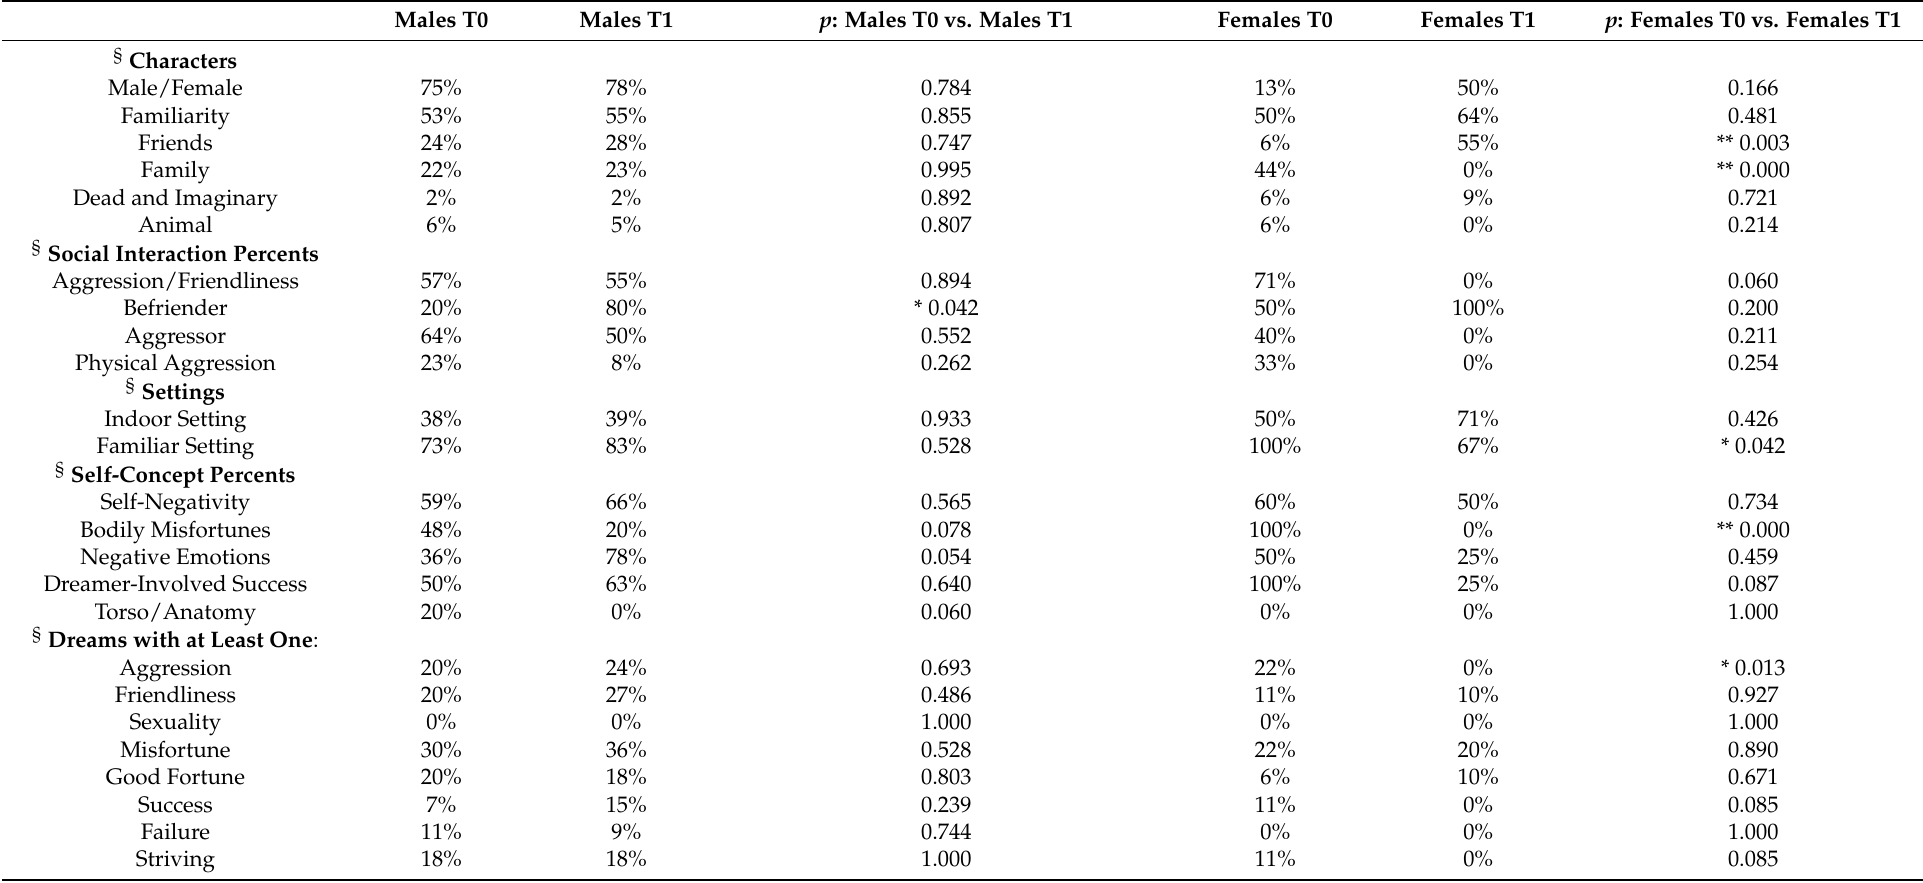
Table 3. Male T0 vs. T1 and Female T0 vs. T1. Males T0 Males T1 p : Males T0 vs. Males T1 Females T0 Females T1 p : Females T0 vs. Females